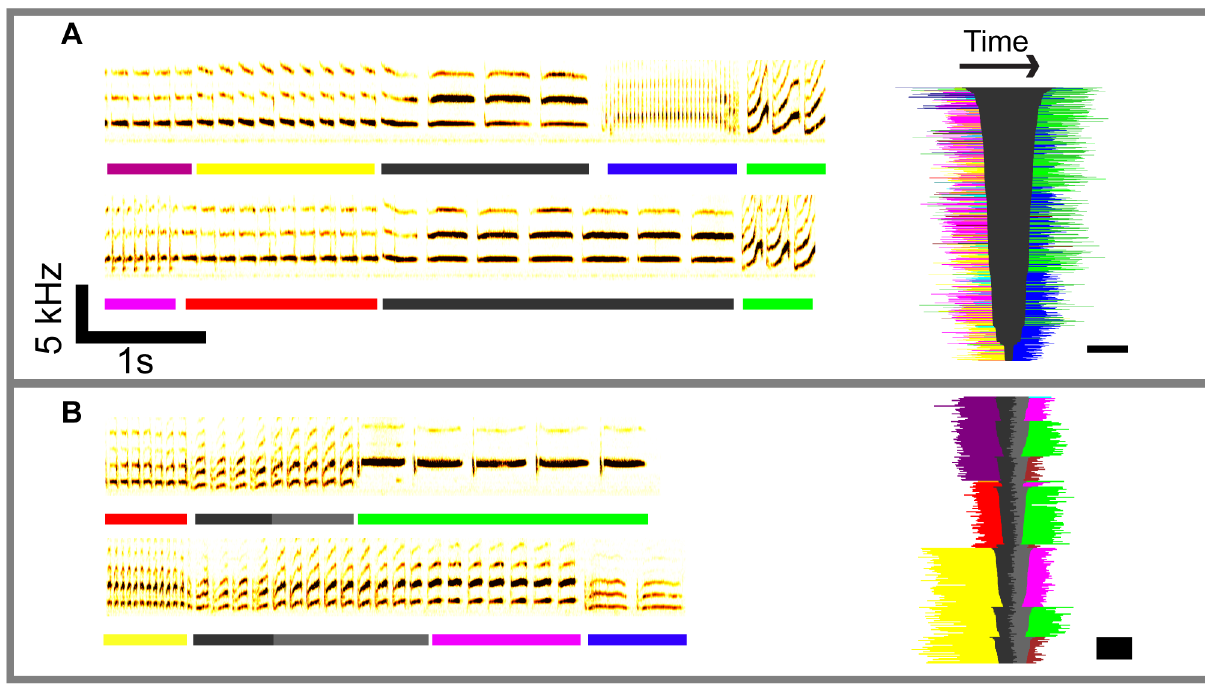
Figure 1. Sonograms show a relationship between phrase duration, the context of a phrase, and future choices. Phrases consist of repetitions of elementary units—the syllables. Distinct phrase types are indicated by colored bars beneath each sonogram. On the right side of each sonogram is a ‘‘barcode’’ summary of all occurrences of the phrases shown in the sonograms. The phrases before (left) and after (right) the gray phrase are color-coded by syllable identity, and the length of the bars in each row indicates duration of the phrase. A square flanks each barcode to indicate the scale, with the width corresponding to 2 seconds and the height to 20 trials. A , A case where the duration of a phrase predicts the future path—the barcode is sorted by duration of the black phrase. Short black bars on the bottom of the barcode typically lead to blue, while long black bars at the top typically lead to green. B , A case where the identity of the starting phrase (red, yellow, or purple) determines which phrase type comes after the black/gray phrase (green or magenta for example.) The barcode in this panel is sorted by the phrase that comes before the black/gray phrase.